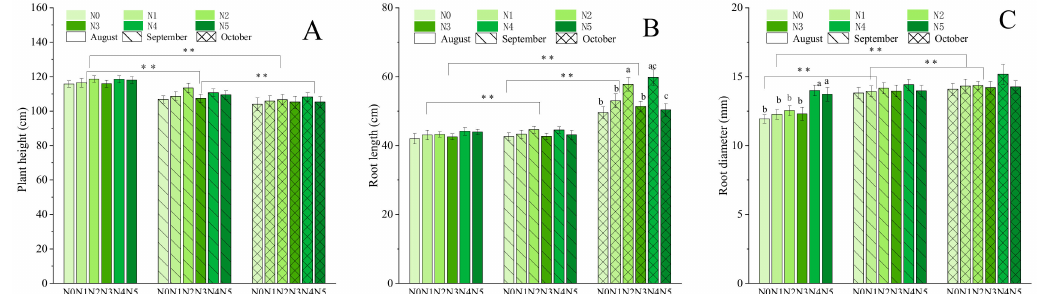
Figure 1. Plant height (cm), root length (cm), and root diameter (mm) in response to di ff erent nitrogen levels: 0 kg / ha (N0, control), 37.5 kg / ha (N1), 75 kg / ha (N2), 112.5 kg / ha (N3), 150 kg / ha (N4), and 187.5 kg / ha (N5), and harvest stages from August to October. ( A ) Plant height from August to October; ( B ) root length from August to October; ( C ) root diameter from August to October, respectively. Significant di ff erences at p < 0.05 are indicated by di ff erent letters. Significant di ff erences at p < 0.01 are indicated by ** between